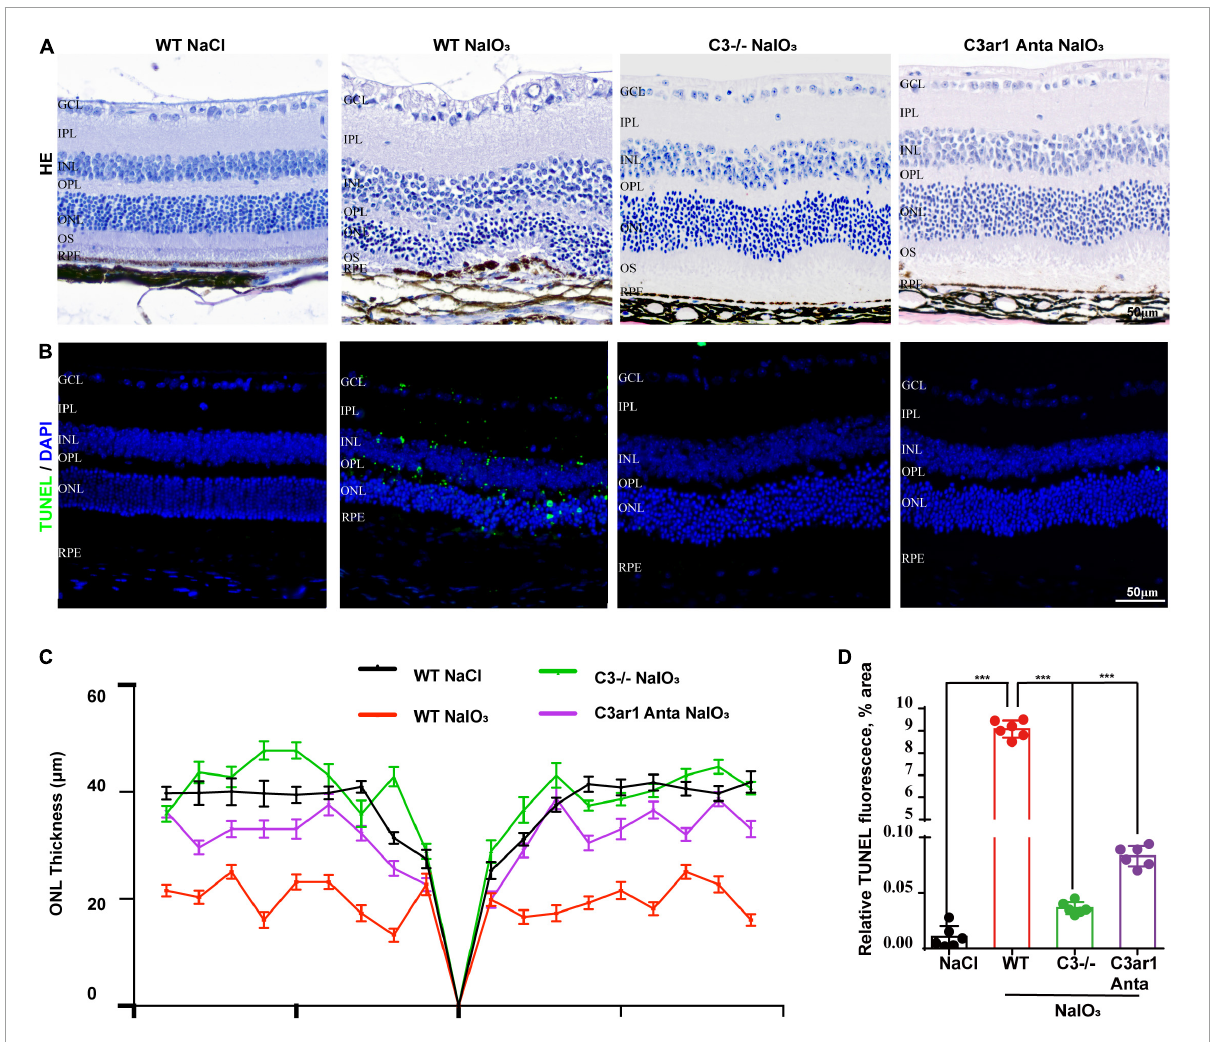
FIGURE5 Genetic deletion of C3 and inactivation of C3ar1 protects the neural retina structure. (A) H&E staining of retinas of saline control- and NaIO3-treated WT, C3-KO and C3ar1-inhibited mice. (B) TUNEL immunofluorescence staining of retinas of saline control- and NaIO 3 -treated WT, C3-KO and C3ar1-inhibited mice. (C) Quantification of ONL thickness in the retinas of saline control- and NaIO3-treated WT, C3-KO, and C3ar1-inhibited mice. (D) Immunofluorescence staining and quantification of TUNEL in retinas of saline control- and NaIO3-treated WT, C3-KO, and C3ar1 inhibition